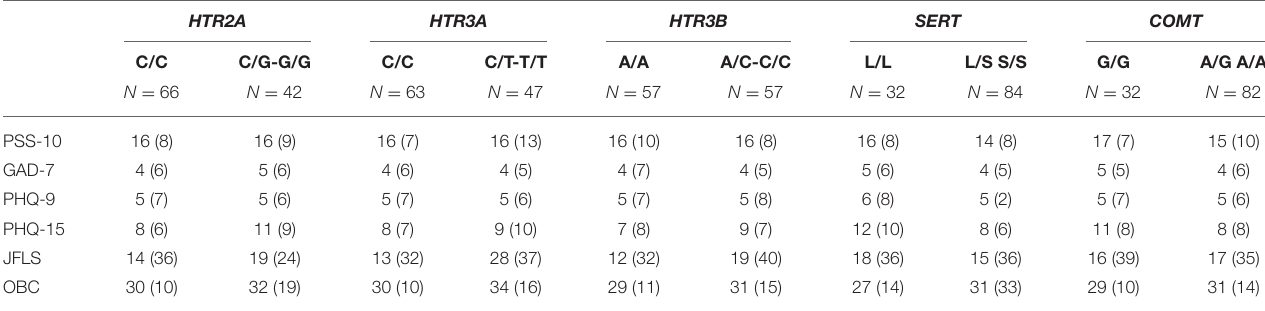
TABLE 3 | The median (IQR) scores for stress (PSS-10), anxiety (GAD-7), depression (PHQ-9), somatic symptoms (PHQ-15), jaw functional limitation (JFLS), and parafunctions (OBC) in the common homozygous and rare homozygous combined with the heterozygous genotypes of the HTR2A (rs9316233) , HTR3A (rs1062613)